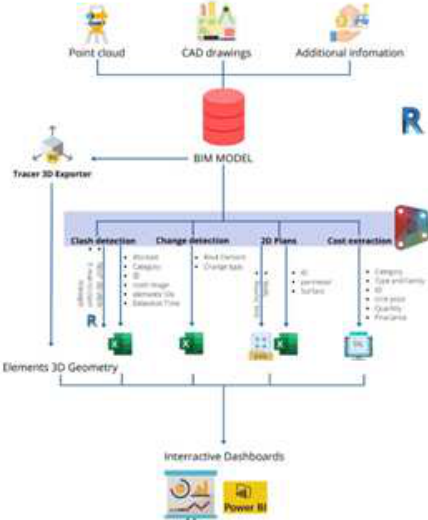
Figure 1. The workflow of our methodology.